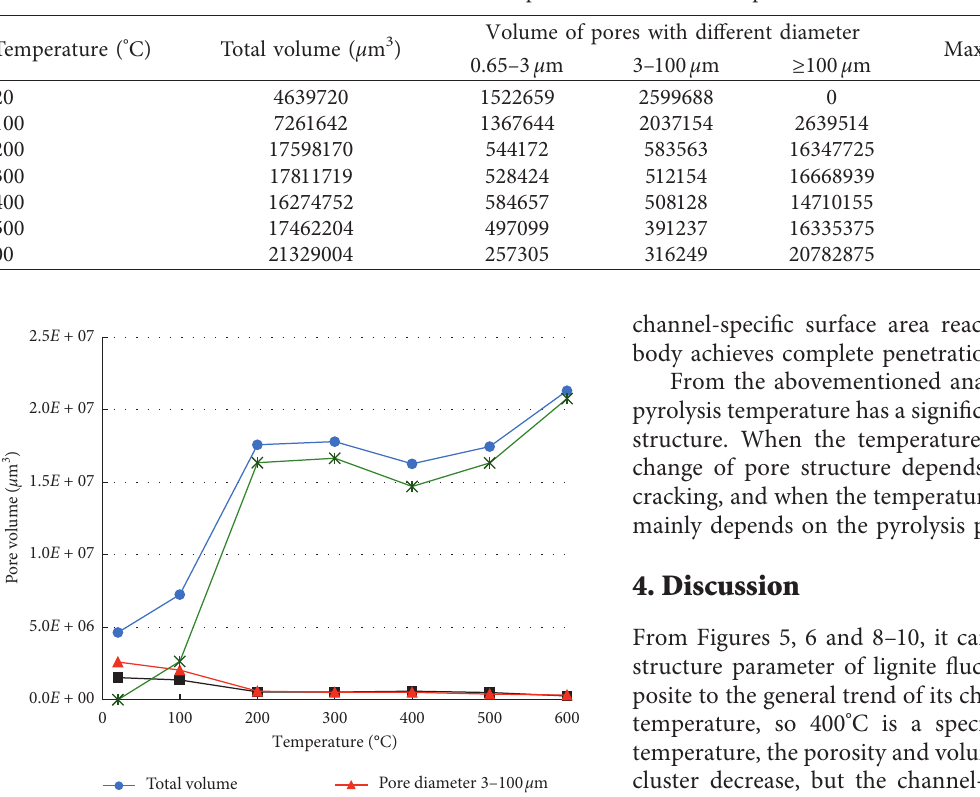
Table 3: Volume of pore and the maximum pore diameter.